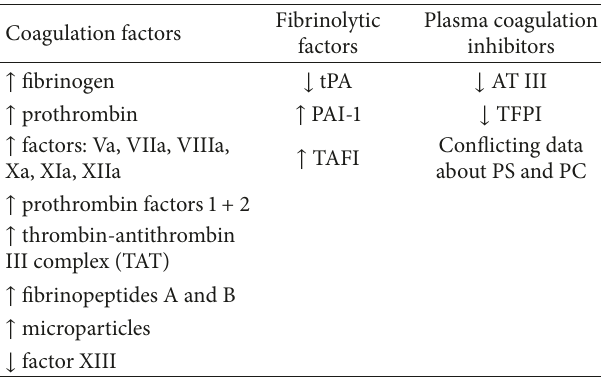
Table 2: Abnormalities in coagulation, anticoagulation, and fibri- nolytic system in IBD patients